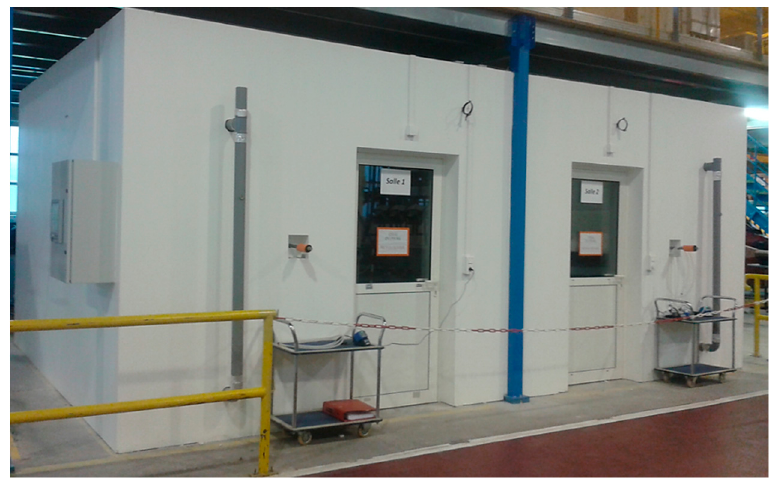
Figure 4. Full-scale test chamber in the CRIR.